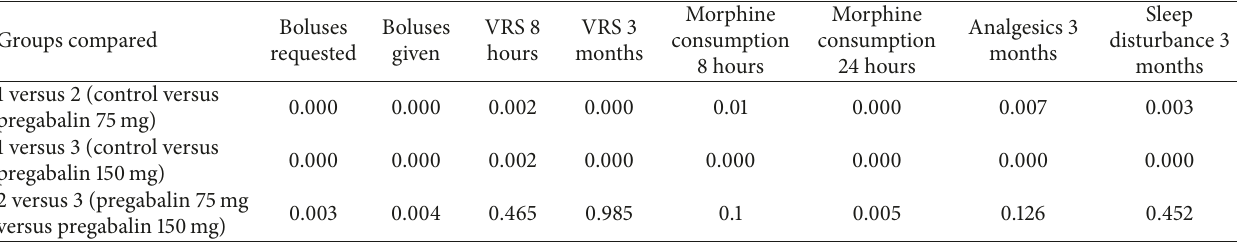
Table 3: Post hoc comparisons between groups using the Mann–Whitney test.